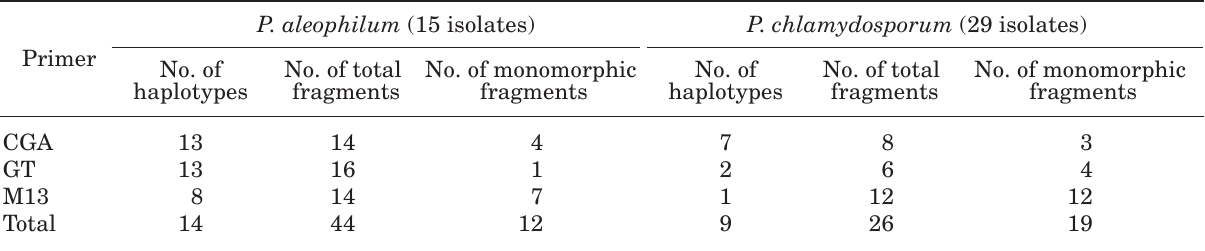
Table 4. Number of haplotypes, and of total and monomorphic fragments obtained with each RAMS primer from Phaeoacremonium aleophilum and P. chlamydosporum